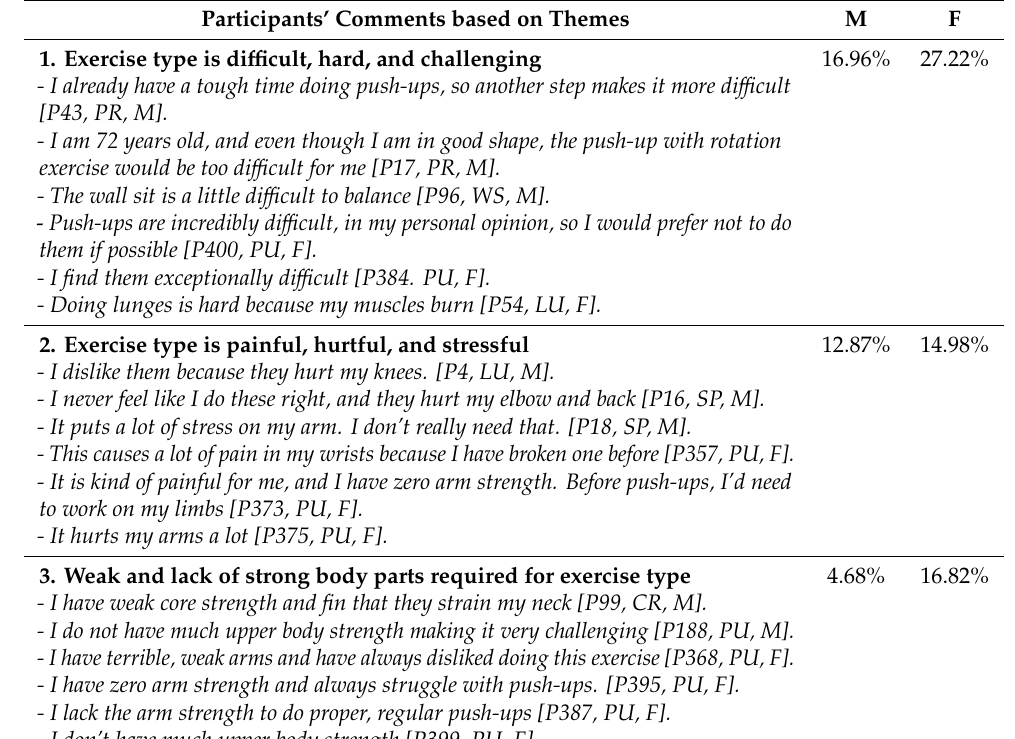
Table A2. Sample comments supporting teased-out barriers against users’ least preferred target exercise types. SQ = squat, CR = crunch, PL = plank, SP = side plank, CD = chair dip, LU = lunge, PU = push-up, PR = push-up and rotation, WS = wall sit, SU = step up, RIP = running in place, JJ = jumping jack, M = male, F =